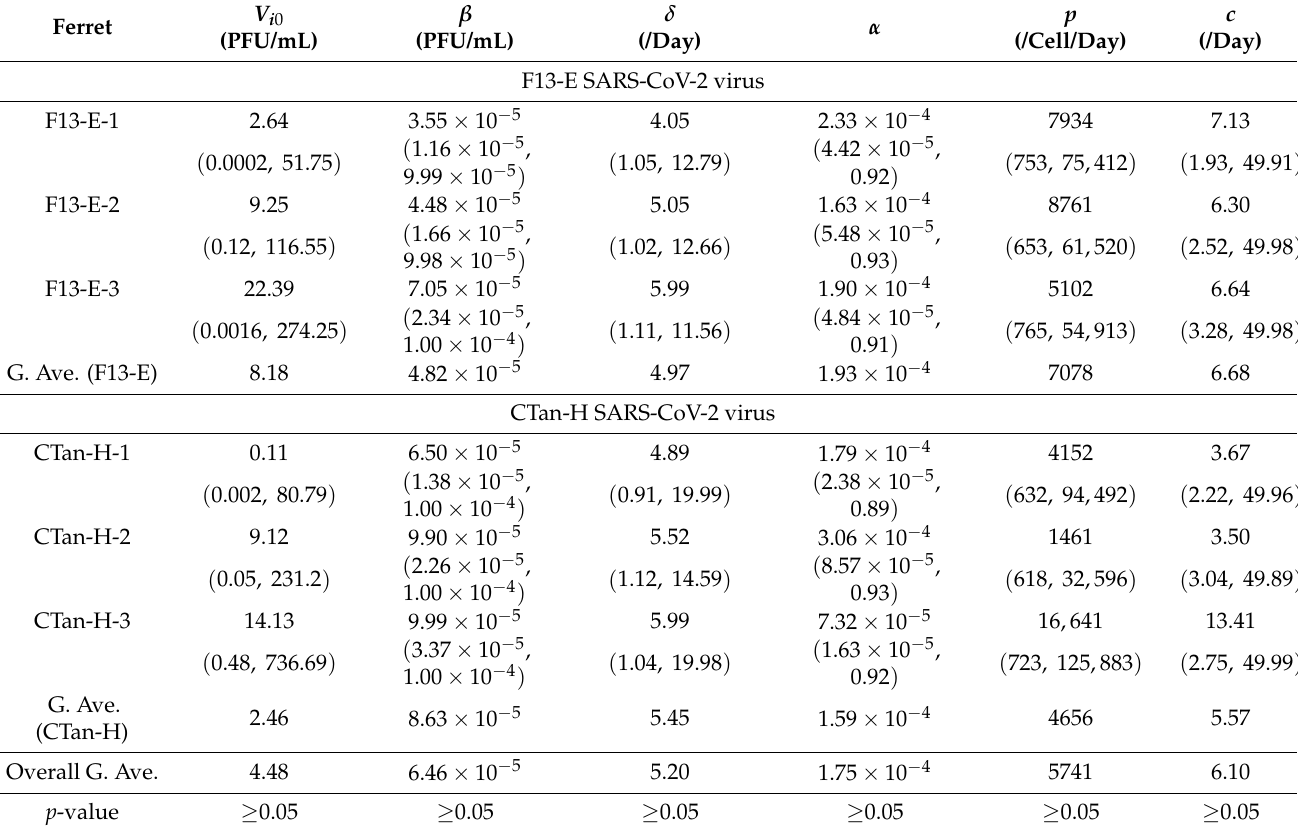
Table 1. Parameters of Model 1 estimated from the data fitting. G. Ave. stands for geometric average. p -values indicate the result of comparison between F13-E and CTan-H